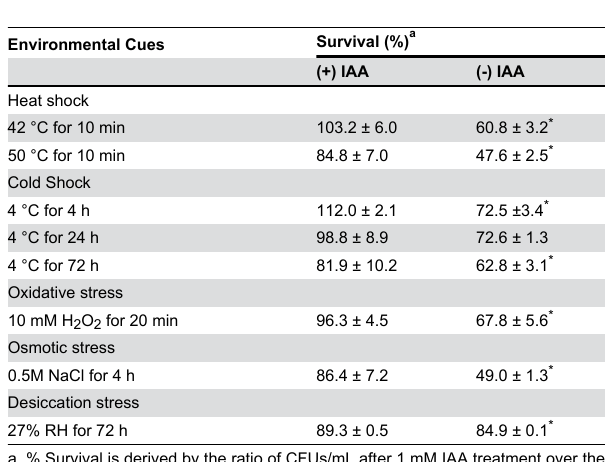
Table 2. Increased stress tolerance of B. japonicum after exposure to